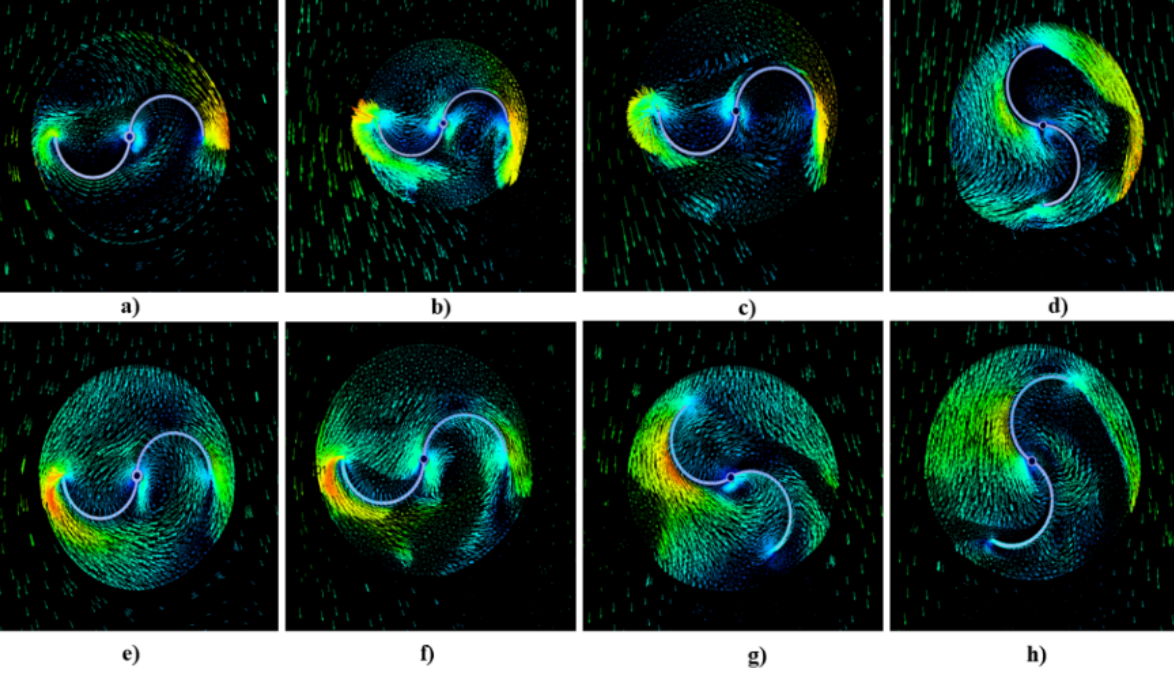
Figure 16: Vector of velocity on a) Rotor Single Stage, b)Rotor Two-Stage 0 ∘ , c) First Stage Rotor Two-Stage 90 ∘ , d) Second Stage Rotor Two-Stage 90 ∘ , e) Rotor Three Stage 0 ∘ , f) First Stage Rotor Three Stage 120 ∘ ,g) Second Stage Rotor Three Stage 120 ∘ , and h) Third Stage Rotor Three Stage 120 ∘